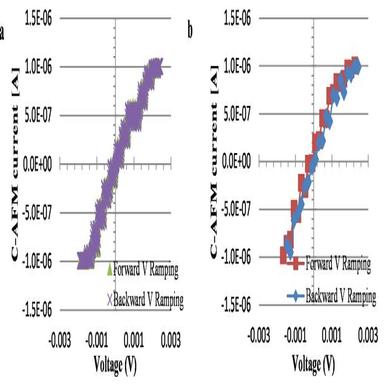
(a) Representative approach force curve (FD curve) of gold thin film and (b) corresponding approach CAFM current respond detected by CAFM module. (c) Shows the retract FD curve of gold thin film and (d) corresponding detected Retract-CAFM current respond. The cartoon at the inset of (a) and (c) shows the conductive CAFM tip and gold substrate before and after contact with the surface of gold to illustrate the reasons for some of the changes took place in each graph. (e) Shows all graphs of the force vs cant